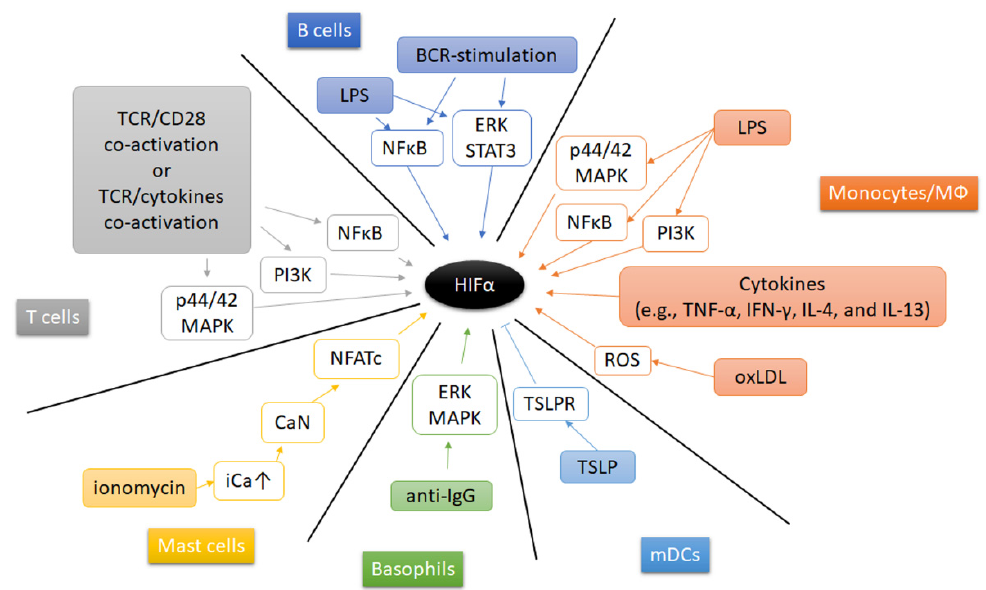
Figure 5. Extracellular regulation of HIF- α . A schematic summarizing the mechanisms underlying the regulation of HIF α activity under diverse physiological and pathological conditions. Arrow indicates activation, and bar-headed line indicates inhibition.